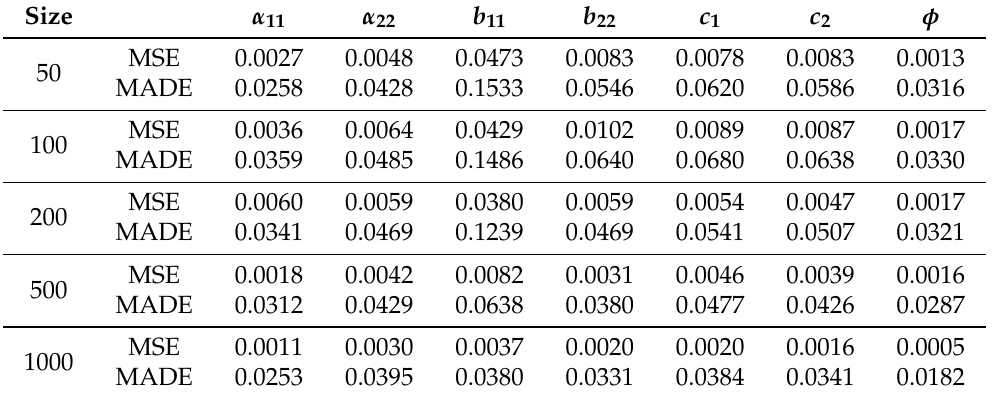
Table 4. Results for diagonal EBINAR(1) model with parameter III.